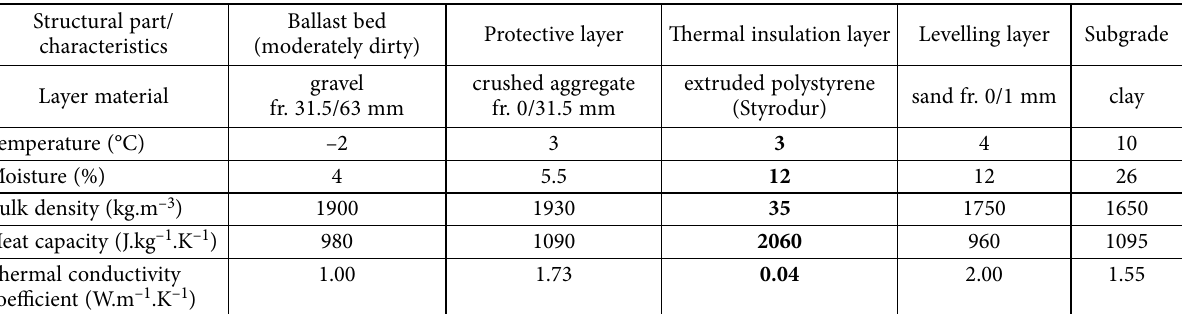
Table 4. Input material characteristics of numerical